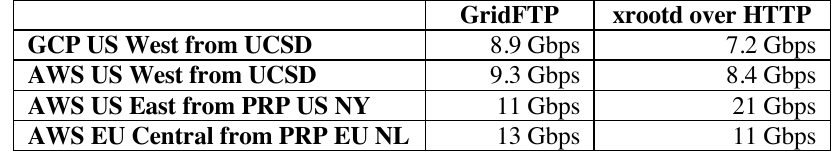
Table 5. Observed peak throughput downloading a 10GB file from a single on-prem server into a single Cloud